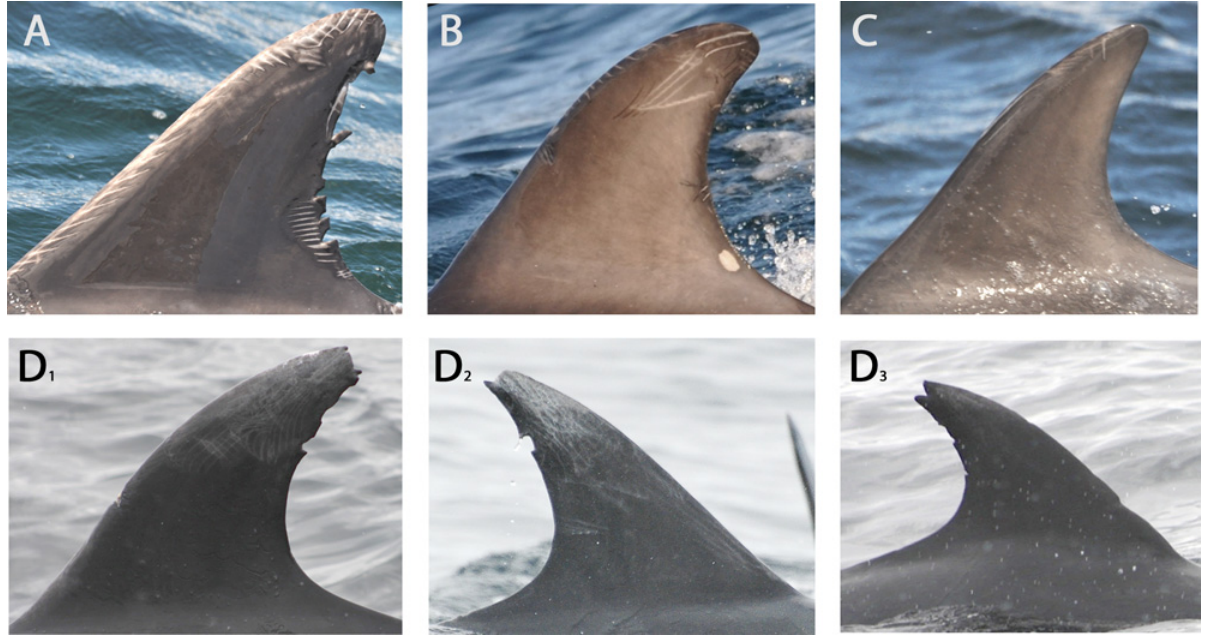
Fig 2. Grades of severity of dorsal fin scarification. Examples of the mark severity grades of dorsal fin scarification as applied in this study. (A) Permanently marked, (B) Temporarily marked, (C) Superficially marked, (D1-3) Permanently marked with damage to the tip of the dorsal fin. Pictures represent images cropped using Irfanview